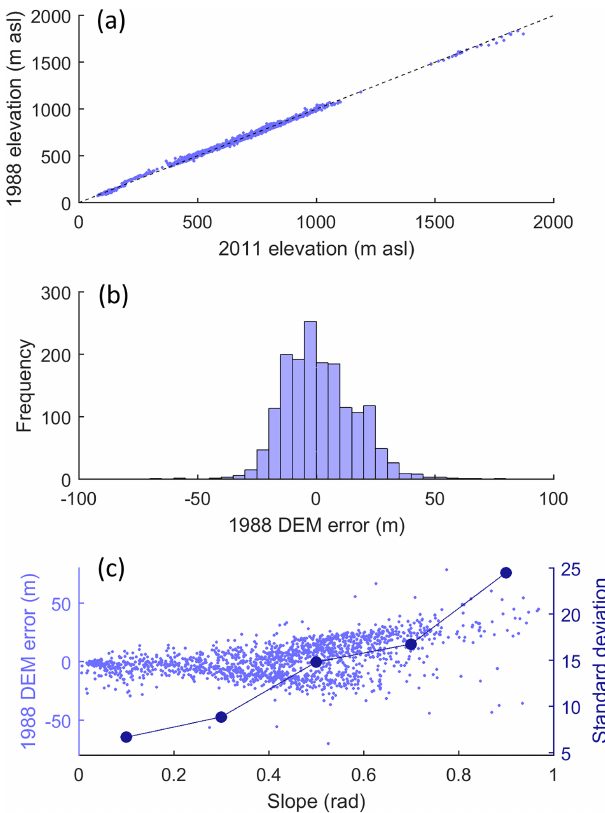
Figure 5. Error model for estimating uncertainty in glacier vol- ume change between 1988 and 2011 including 1988 vs. 2011 off- ice DEM elevations (a) , distribution of 1988 DEM errors calcu- lated as the difference between 1988 and 2011 off-ice elevations (b) and estimation of change in standard deviation of errors with the DEM slope (c)